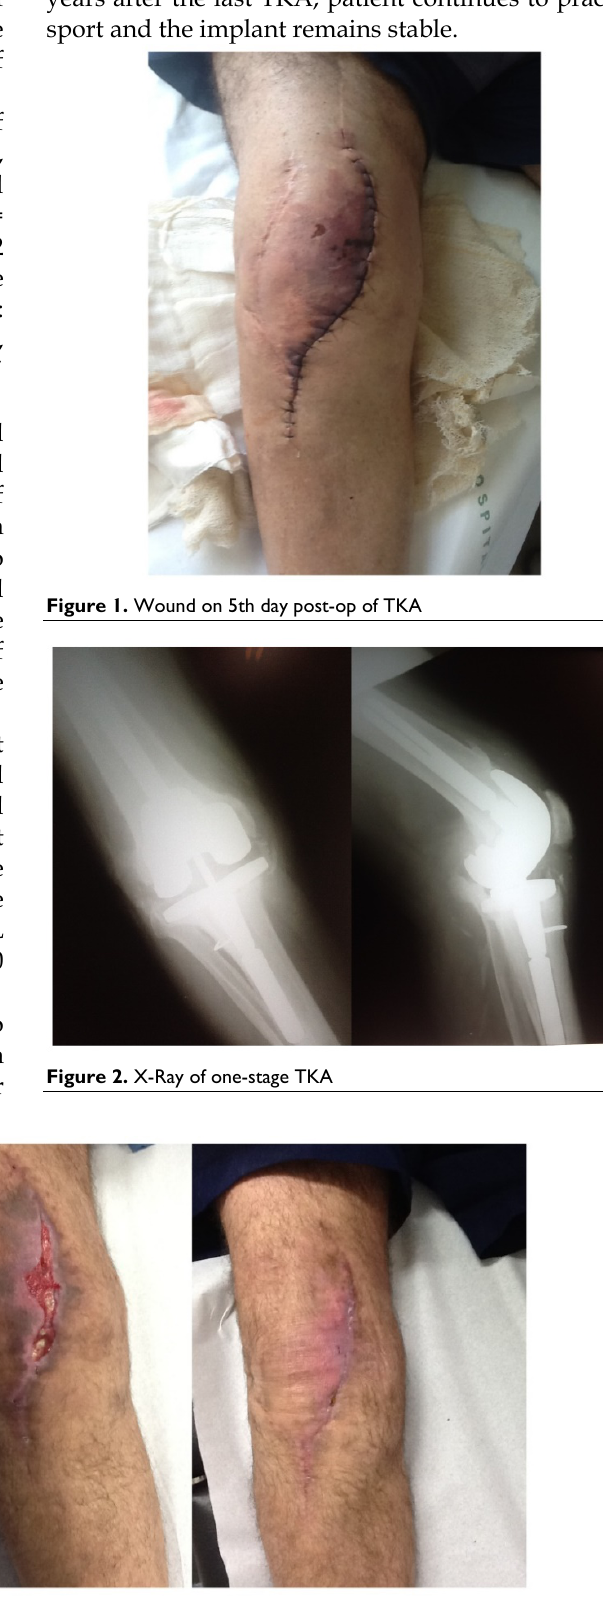
Figure 3. Surgical wound on the 13th, 44th and 79th days post-op respectively during treatment with topical papaina together with oral administration of Linezoilid and